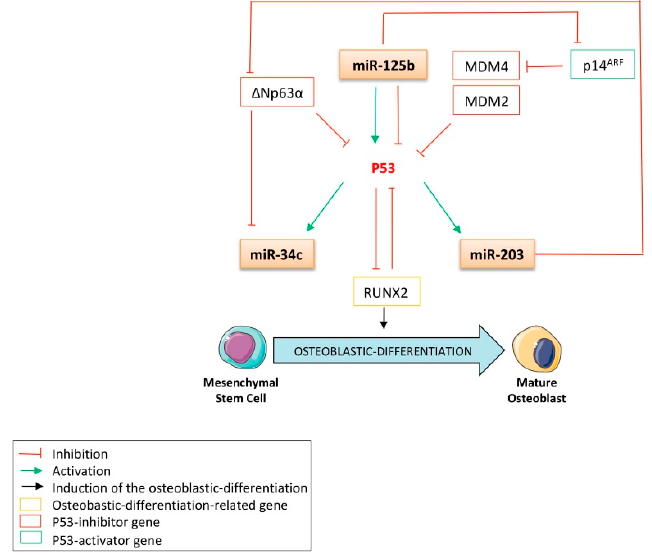
Figure 1. The relationship among p53, the p53 activators, the p53 inhibitors, and the miR-34c, -125b and -203 is essential to control the osteoblastic differentiation. MDM2: mouse double minute 2 homologue; MDM4: mouse double minute 4 homologue; RUNX2: runt-related transcription factor